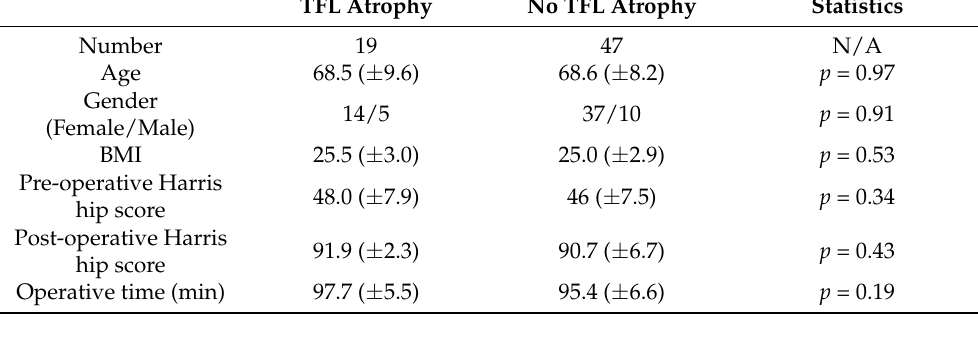
Table 6. Patient demographics and clinical scores in TFL atrophy and no atrophy.